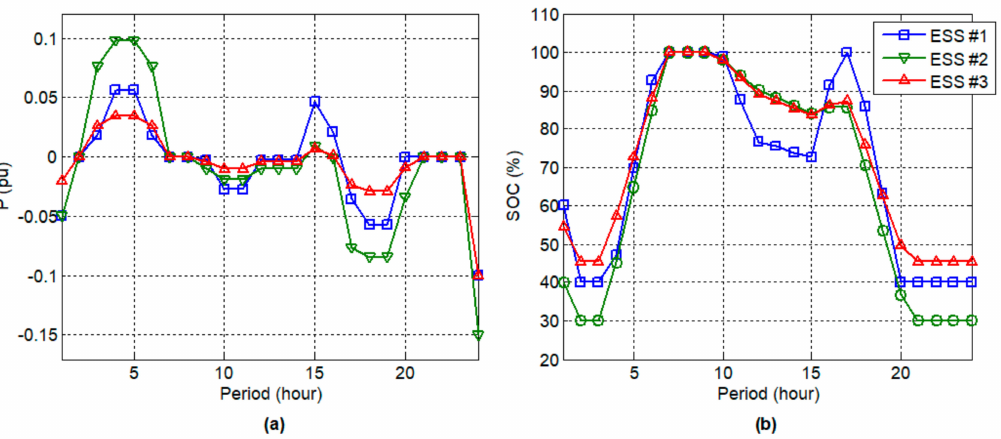
Figure 7. Case I. ( a ) Charging profile and ( b ) the SOC of each ESS.